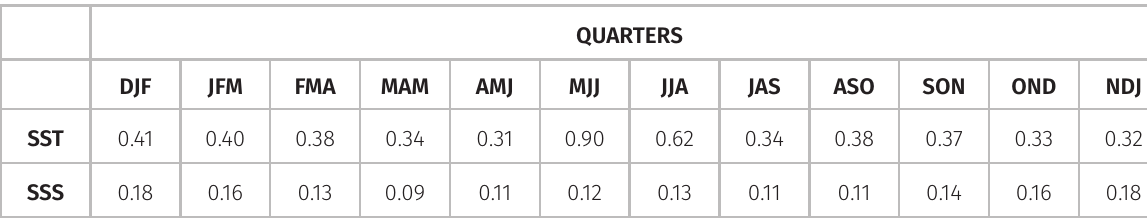
Table II. Seasonal RMSE between layerctl ensemble experiment (2020–2030) and SODA3.3.1 reanalysis (2006–2015) for sea surface temperature (SST, in °C) and sea surface salinity